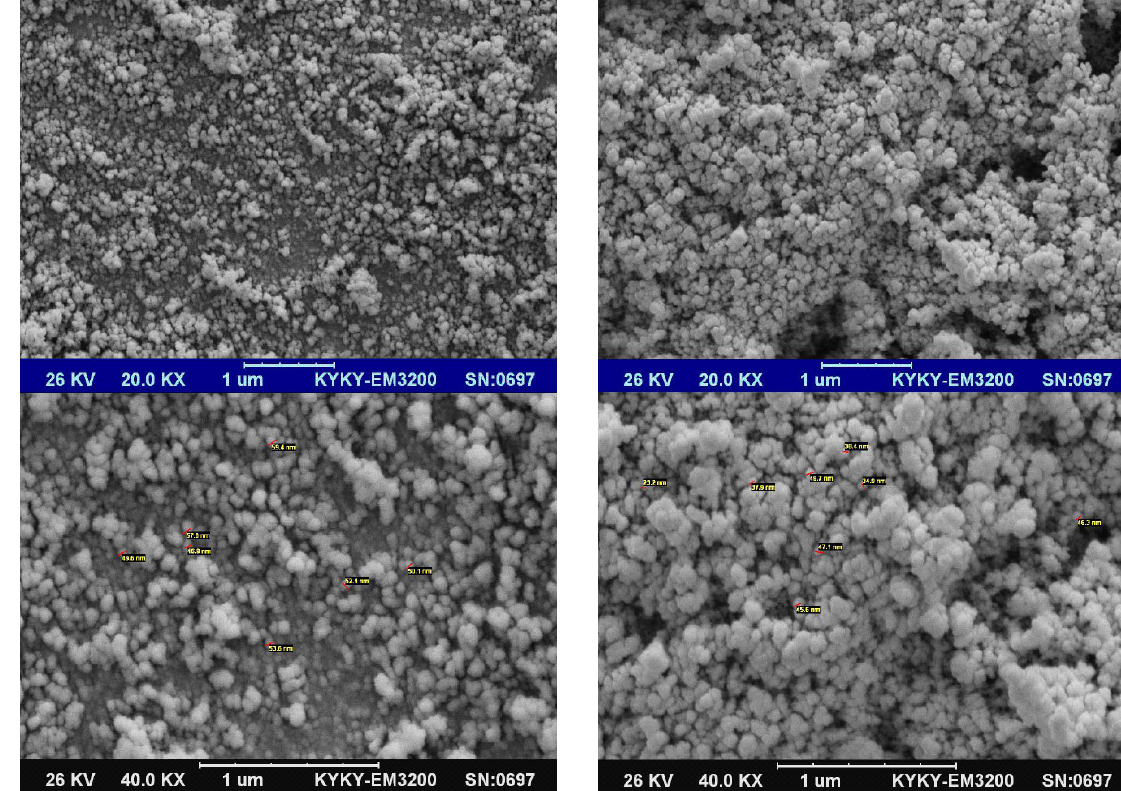
Fig. 3. SEM images of Fe